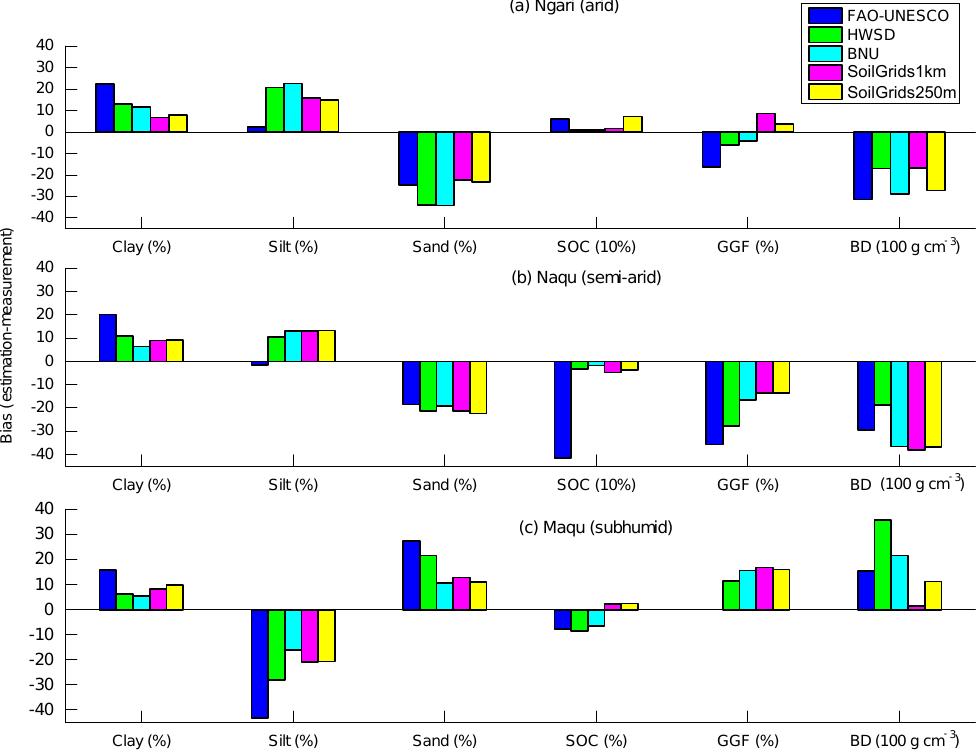
Figure 11. Average bias in soil basic properties between the existing products and the laboratory measurements taken for the three climate zones. To enable the comparison of BD with the same order of magnitude as other properties, the original BD was multiplied by 100 (with unit × 100gcm − 3 ). Likewise, a multiplication (% × 10) is applied to SOC data on the semi-arid zone. FAO-UNESCO is the FAO-UNESCO Soil Map of the World (2007). HWSD is the Harmonized World Soil Database (FAO/IIASA/ISRIC/ISSCAS/JR, 2012). BNU is a Chinese dataset of soil properties (Shangguan et al., 2012, 2013) and soil hydraulic parameters using PTFs (Dai et al., 2013) released by Beijing Normal University. SoilGrids1km (Hengl et al., 2014) and the updated version of SoilGrids250m (Hengl, 2017) datasets are released by the International Soil Reference and Information Center (ISRIC) – WoSIS institute. HPSS is the hydraulic parameters of the Van Genuchten (1980) and Mualem (1976) model based on SoilGrids1km and Schaap et al. (2001) PTFs (Montzka et al., 2017).